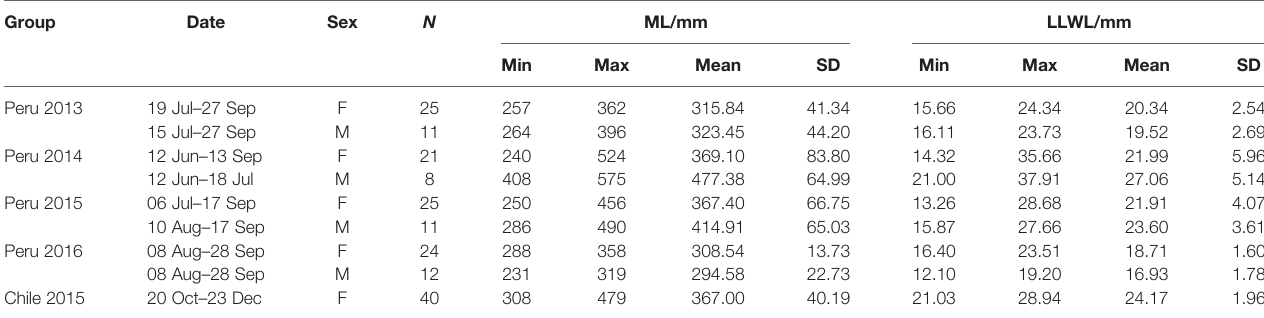
TABLE 1 | Sample information of D. gigas in southeastern Paci fi c (ML corresponds to the mantle length; LLWL corresponds to the lower beak lateral wall length; “ Peru 2013 ” represents samples caught off Peruvian EEZ in 2013, “ Chile 2015 ” represents samples caught off Chilean EEZ in 2015, and so on). Group